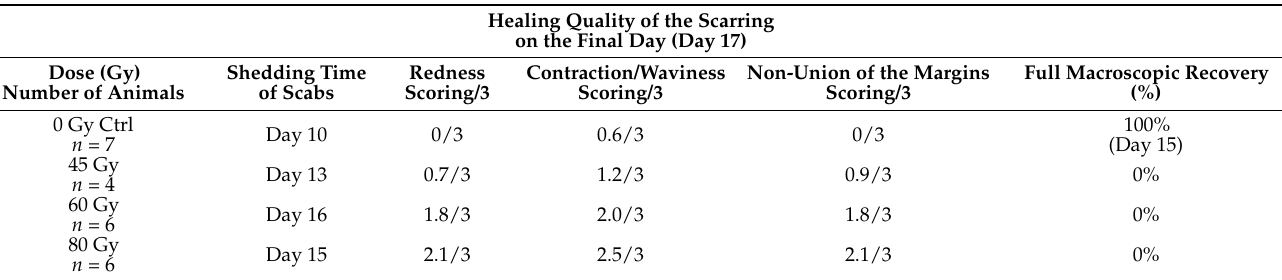
Table 2. Scoring of the appearance of the incisions indicating the severity of the healing complications. Healing Quality of the Scarring on the Final Day (Day 17)